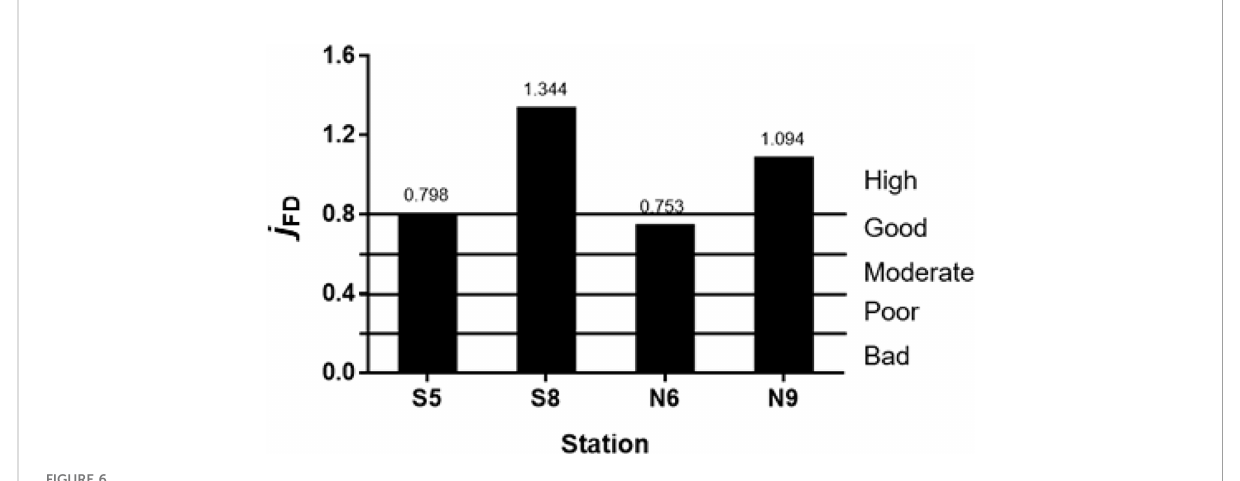
FIGURE 6 Ecological health